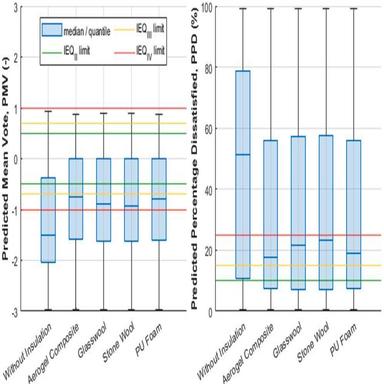
Predicted Mean Vote PMV and Predicted Percentage Dissatisfied PPD for the simulated building with masonry walls using aerogel composite, reference materials and original construction.